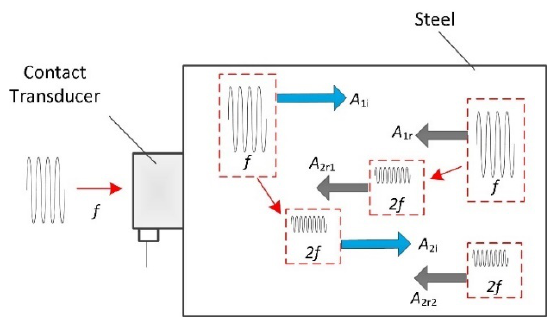
Figure 1. Schematic of a pulse-echo testing configuration with a stress-free boundary.